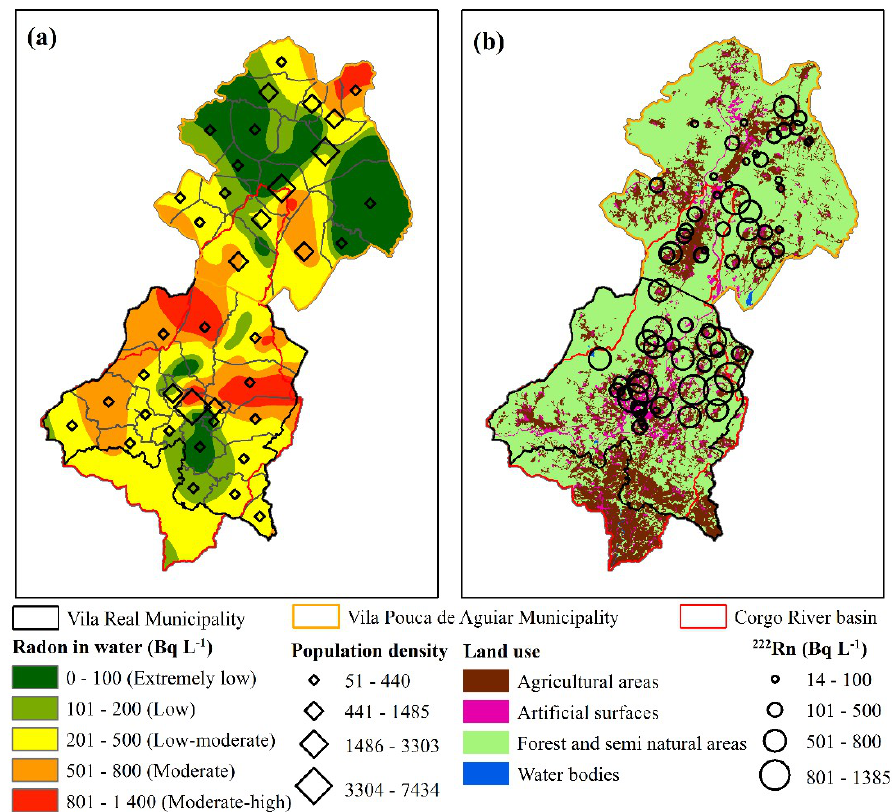
Figure 5. Comparison between interpolated distributions of radon and land-use map: ( a ) Radon risk map for drinking water with the projection of population density; and ( b ) land-use map with water collection points through graduated values.